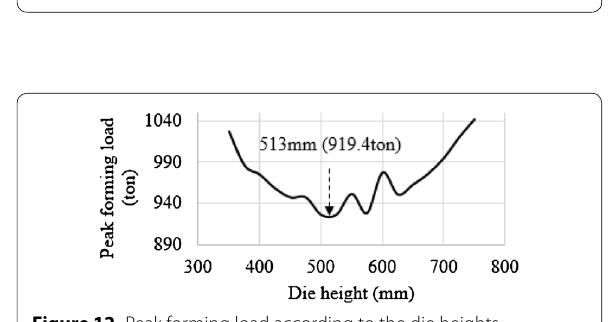
Figure 11 Forming loads according to the times (die height: 500mm)